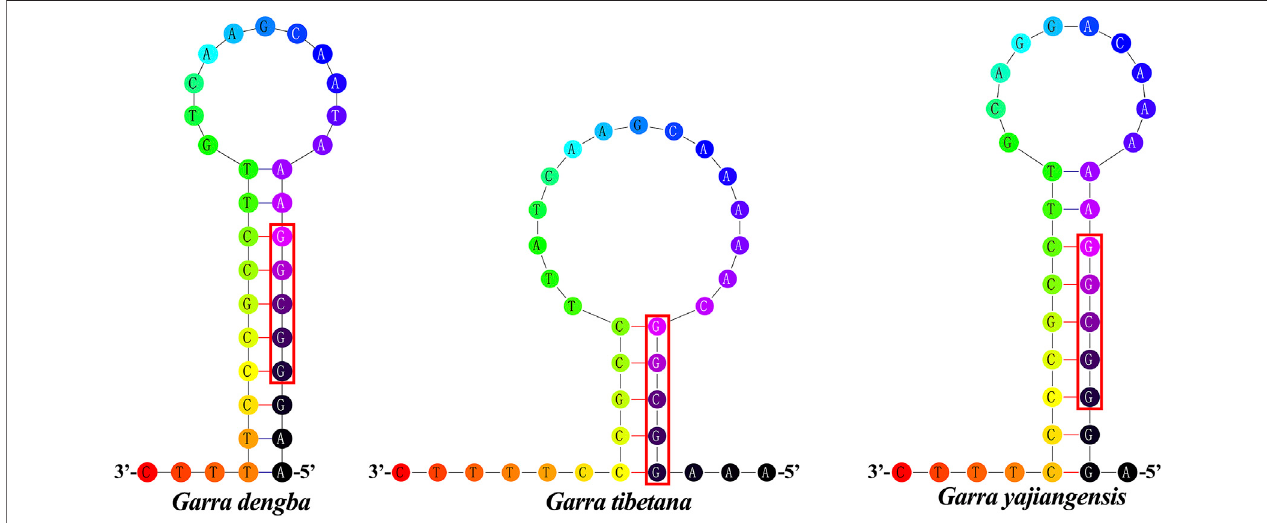
FIGURE 3 | Inferred secondary structures of the OL of Garra mitogenome, (A) Garra dengba , (B) Garra tibetana , and (C) Garra yajiangensis . The OLs of the three Garra mitogenomes were located between tRNA-Asn and tRNA-Cys , and G. dengba and G. tibetana were of the same length (34 bp) and longer than G. yajiangensis (33